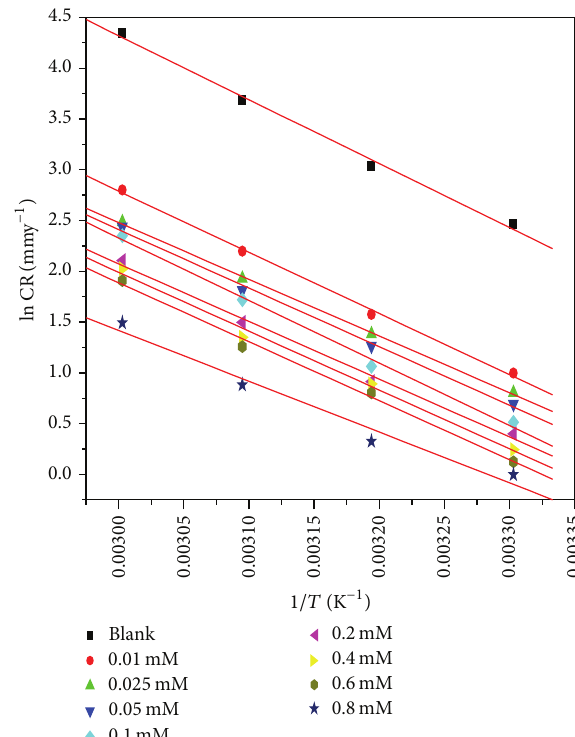
Figure 2: Tafel polarization curves for the mild steel specimen in 1M HCl with various concentrations of HIBH at 40 ∘ C. Figure 3: Arrhenius plots of ln ( CR ) versus 1/ T for mild steel in 1M HCl with different concentrations of